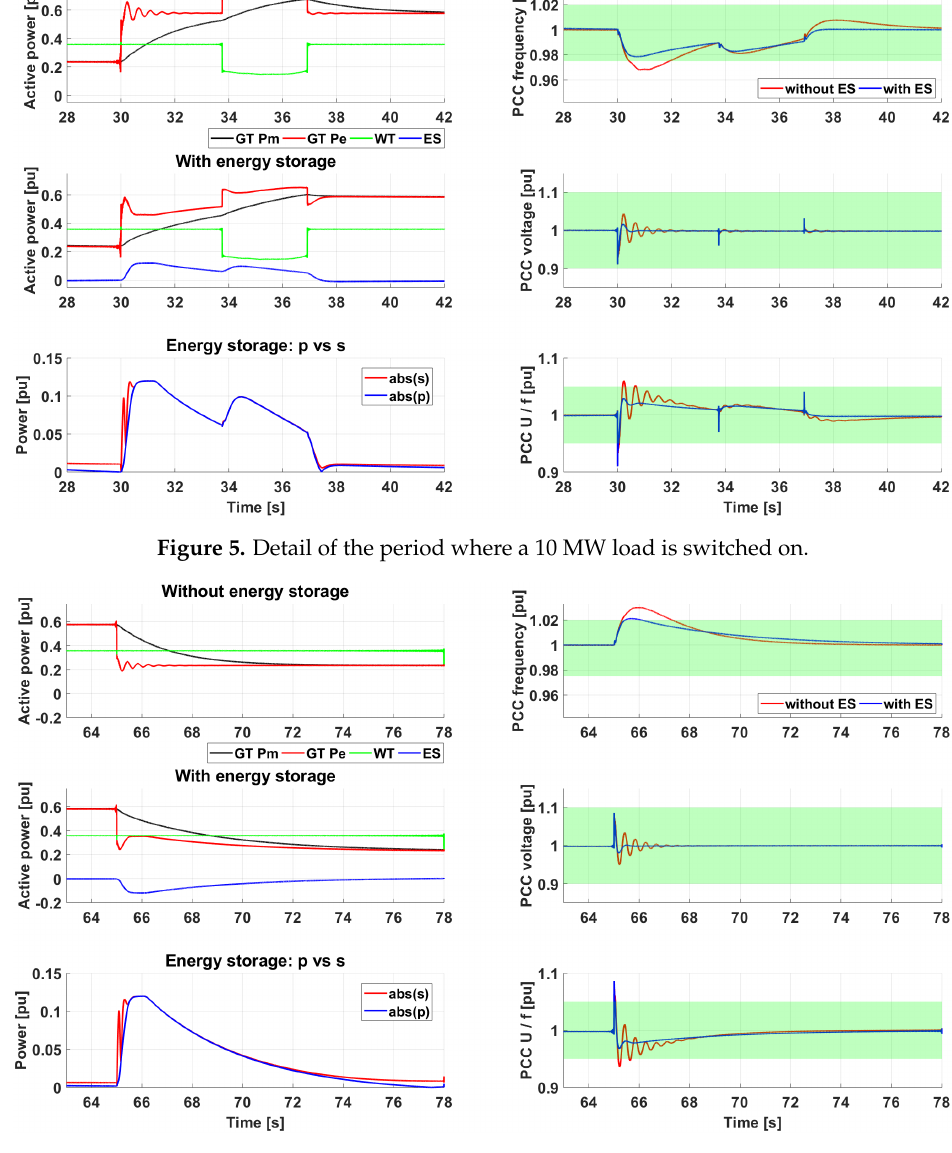
Figure 6. Detail of the period where a 10 MW load is switched off. Table 1. Metrics obtained from the detailed model simulation